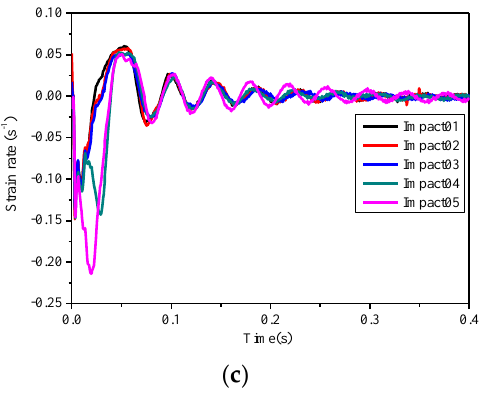
Figure 9. Typical strain and strain rates of the steel tube. ( a ) Strain curves in the tension region of the specimen E-120-I. ( b ) Strain curves in the compression region of the specimen E-120-U. ( c ) Strain rates of in the compression region of the specimen E-120-U.